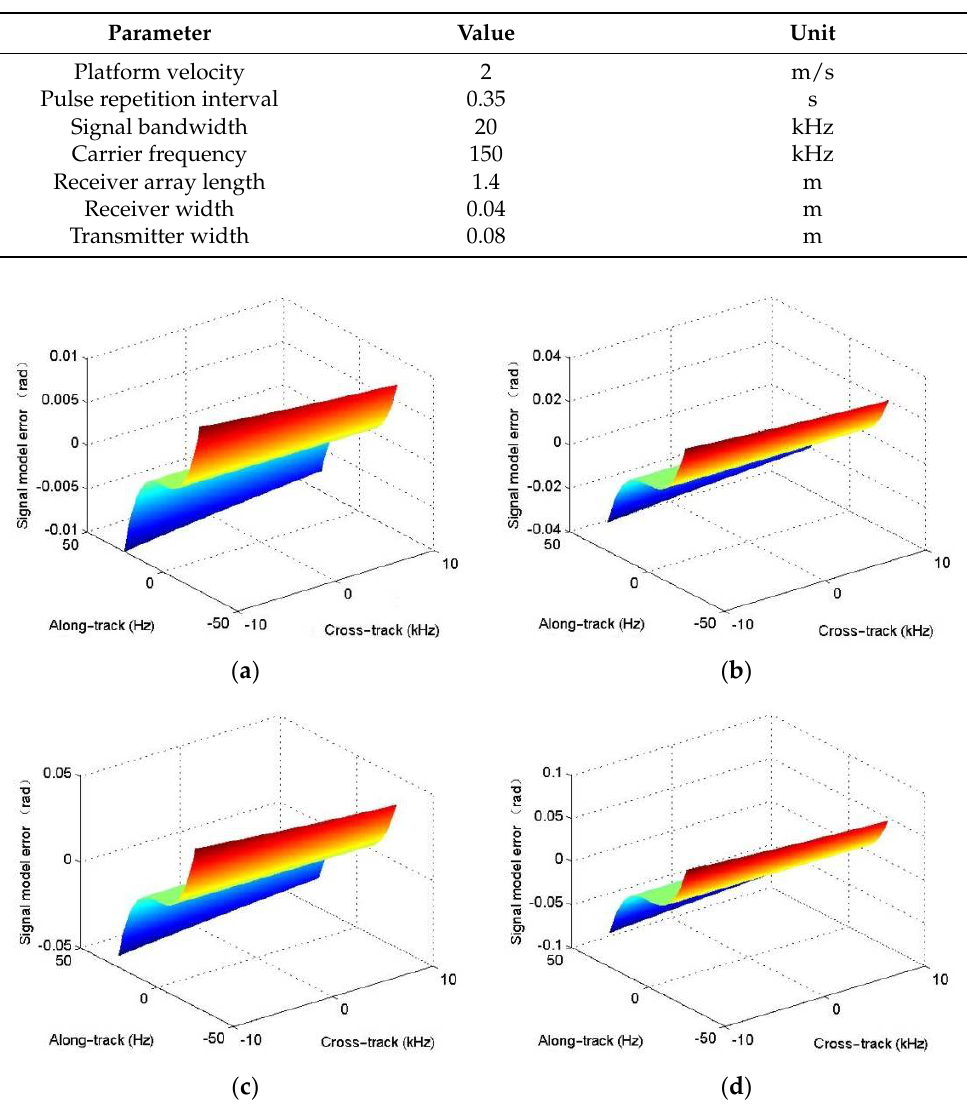
Table 1. SAS parameters with narrow bandwidth.